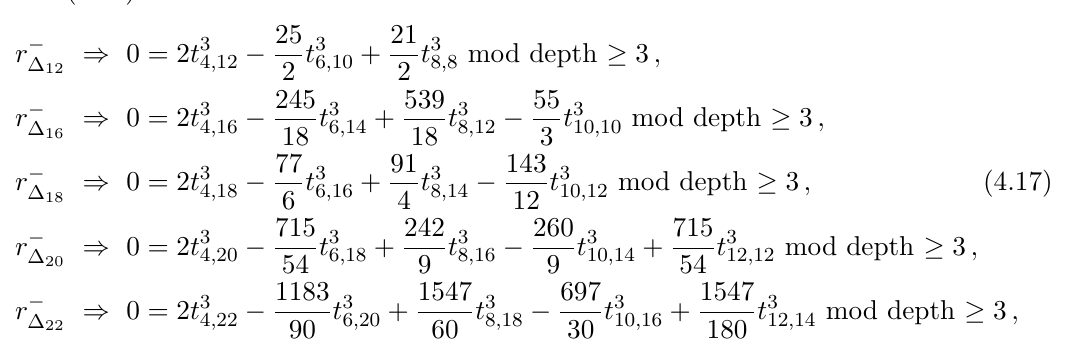
Table 1 . The number given corresponds to the (cid:15) -weight of the indecomposable relation of the given depth triggered by the cusp form ∆ 2 s , so that for instance ∆ 12 induces one indecomposable relation of depth 2 at weight 14 . There are two indecomposable relations of depth 2 , 3 , 4 , . . . at weight 26 , 28 , 30 , . . . , respectively, due to the two cusp forms of modular weight 24 . where t d = 0 since (cid:15) commutes with all the (cid:15) . Indecomposable relations at depth three 2 k 2 ,q due to (4.15) at d = 3